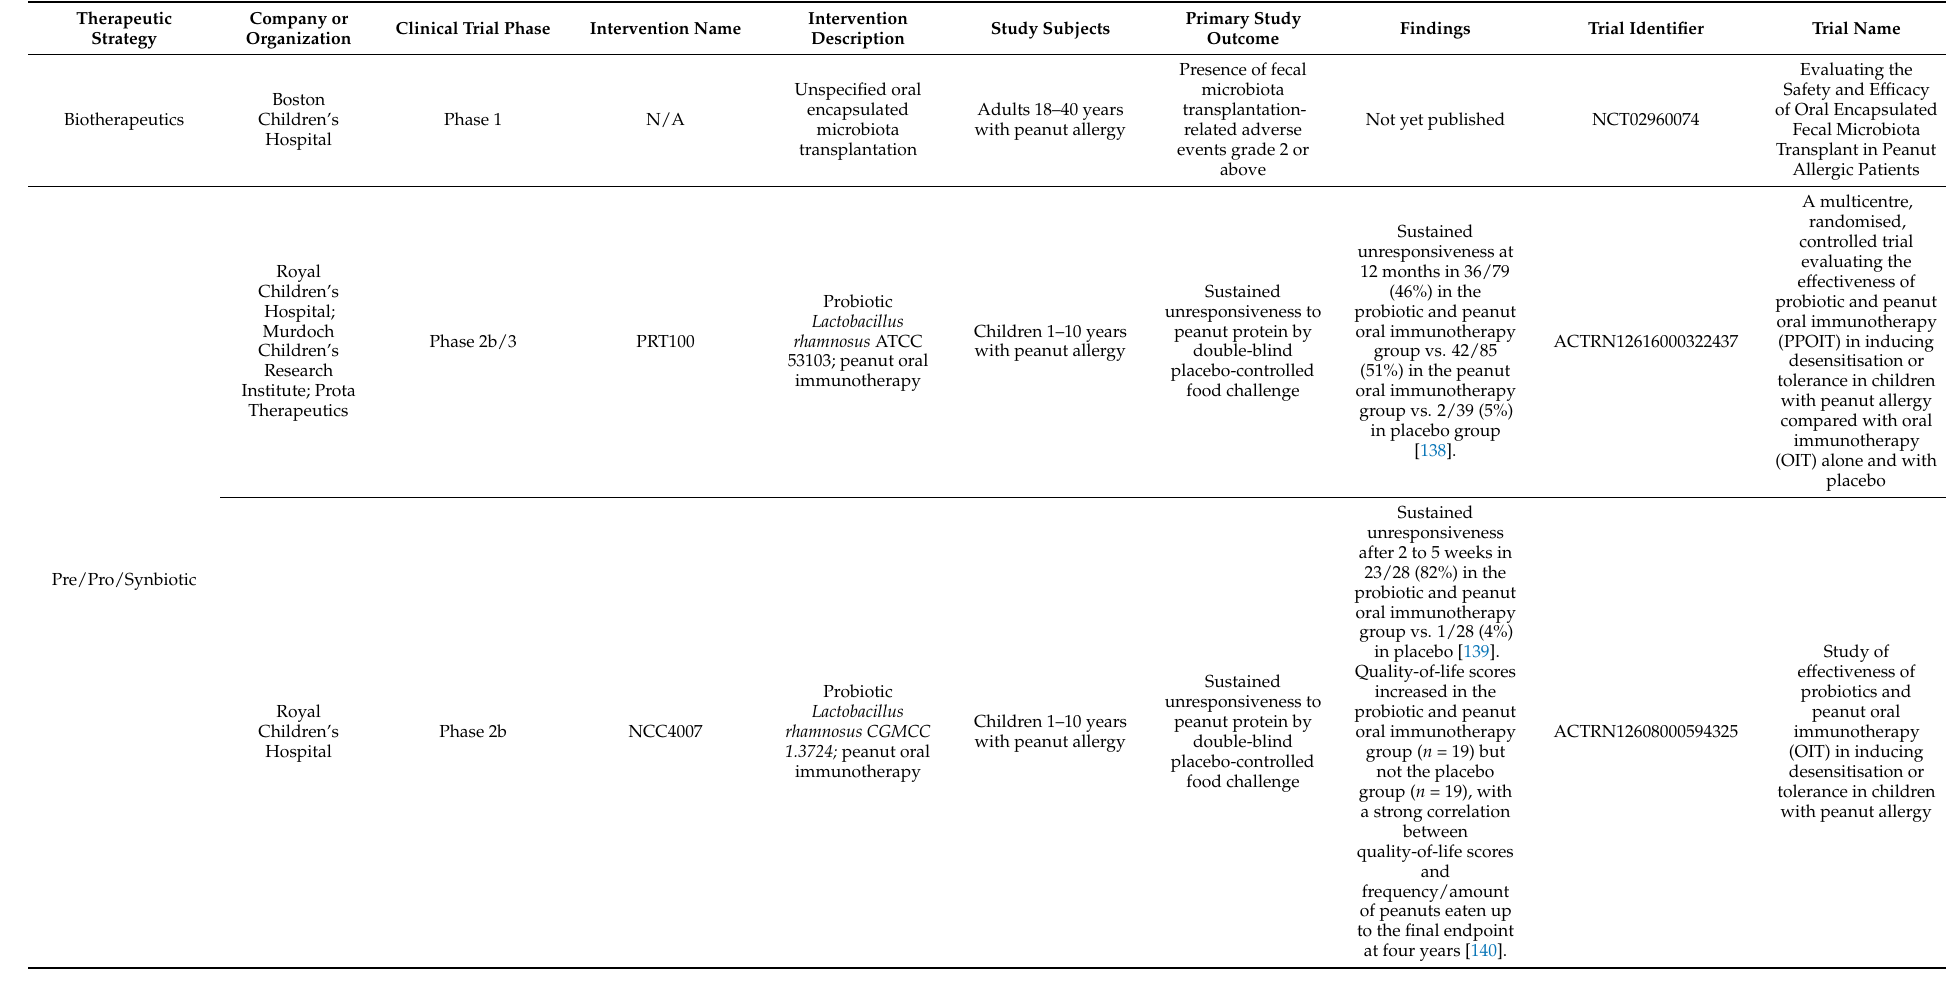
Table 1. Completed clinical trials of microbiome-related therapeutics for food